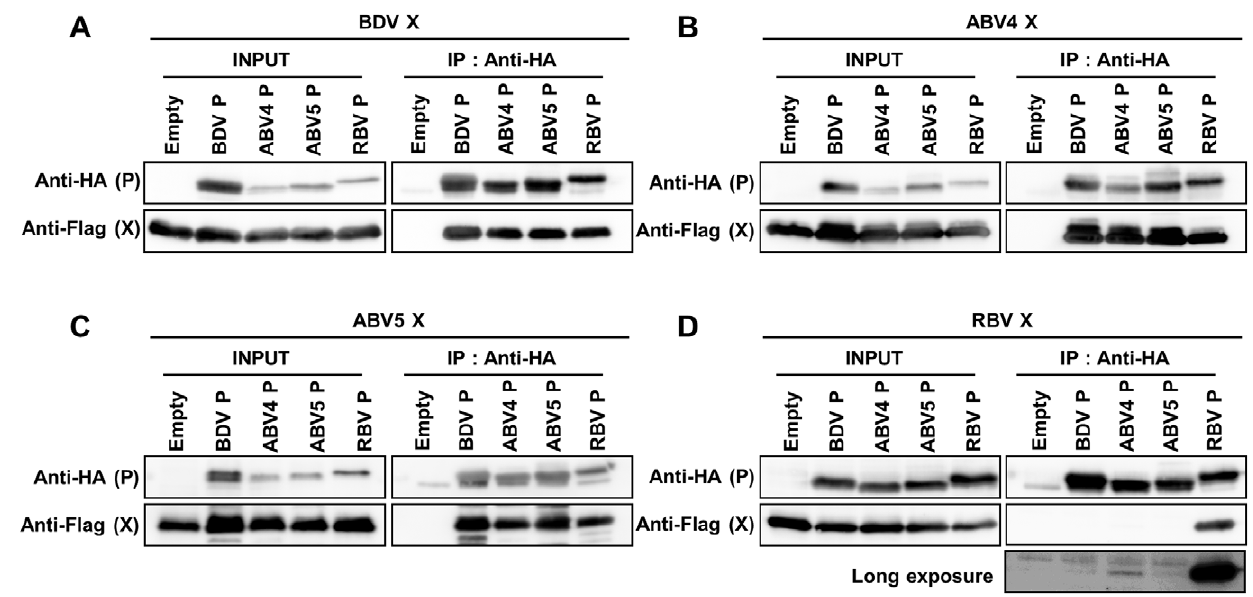
Figure 6. Inter-genotypic interaction between the bornavirus X and P proteins. Immunoprecipitation analysis was carried out using cells co-transfected with plasmids expressing Flag-tagged X proteins of BDV (A), ABV4 (B), ABV5 (C) or RBV (D) and HA-tagged P expression plasmids from each genotype indicated. After immunoprecipitation with anti-HA antibody, the precipitates were detected by anti-Flag antibody. A long exposure image of the membrane is shown for the inter-genotypic interaction of RBV X (D).